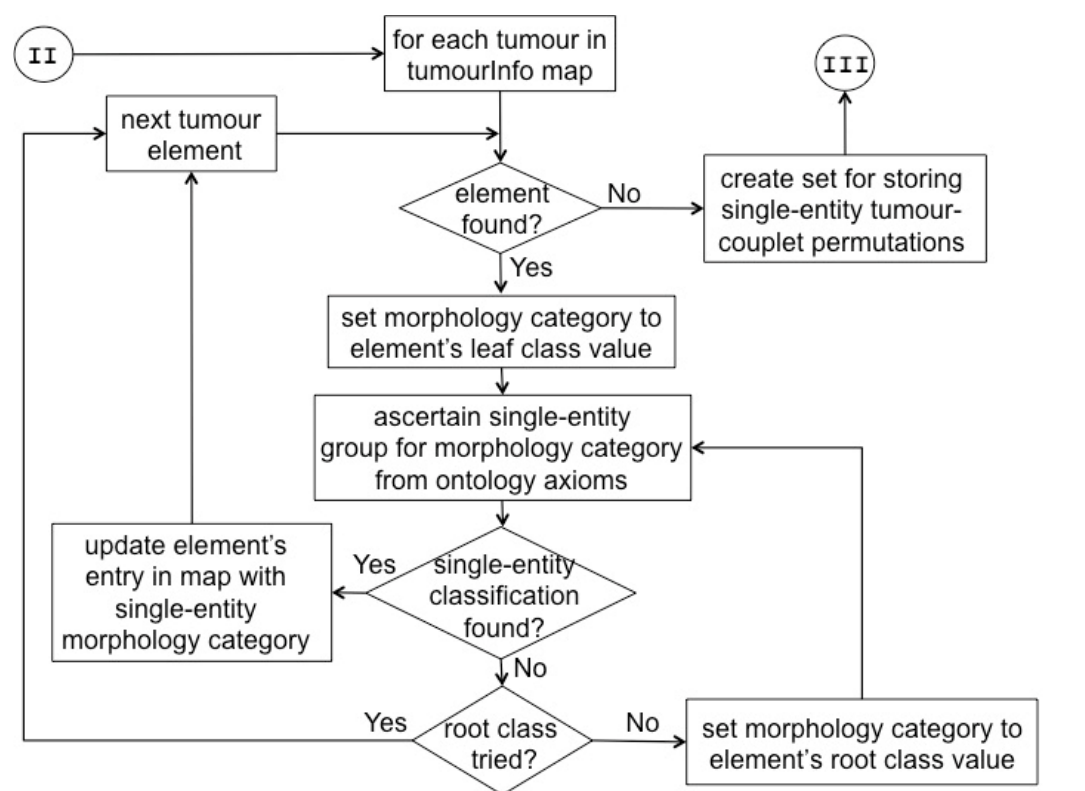
Figure A2. Process for determining from the ontology axioms the single-entity morphology group associated with the morphology category found in Figure A1 from a tumour’s morphology code.